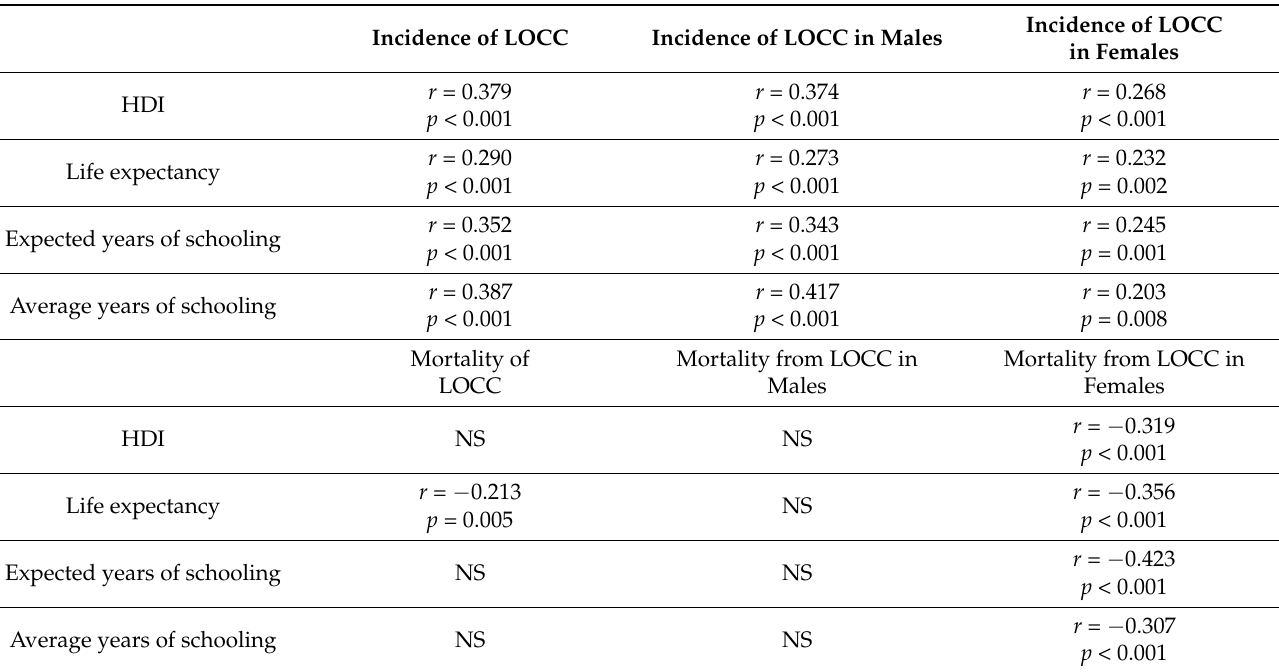
Table 4. Correlation of LOCC incidence and mortality with the HDI. Incidence of LOCC Incidence of LOCC in Males